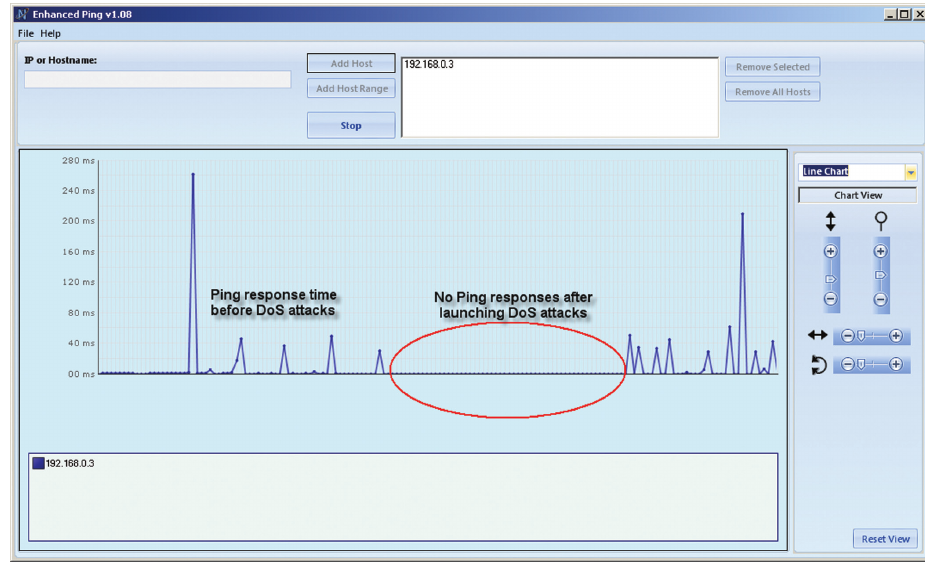
Figure 14. Response Time of Panasonic Iris Reader BM-ET330 Before and After the DoS